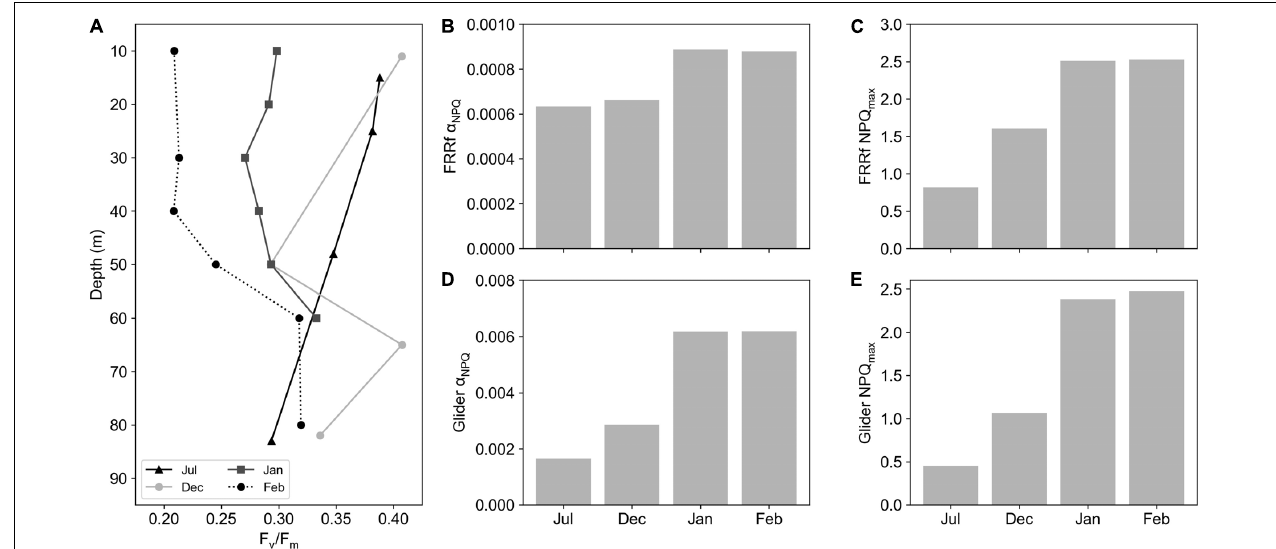
FIGURE 3 | (A) CTD depth profile of F v /F m for July, December, January, and February in the Sub-Antarctic Zone. Bar plots of (B) FRRf derived α NPQ , (C) FRRf derived NPQ max , (D) Glider derived α NPQ and (E) Glider derived NPQ max values from surface CTD FLC samples and coincident Glider profiles in July, December, January, and February.